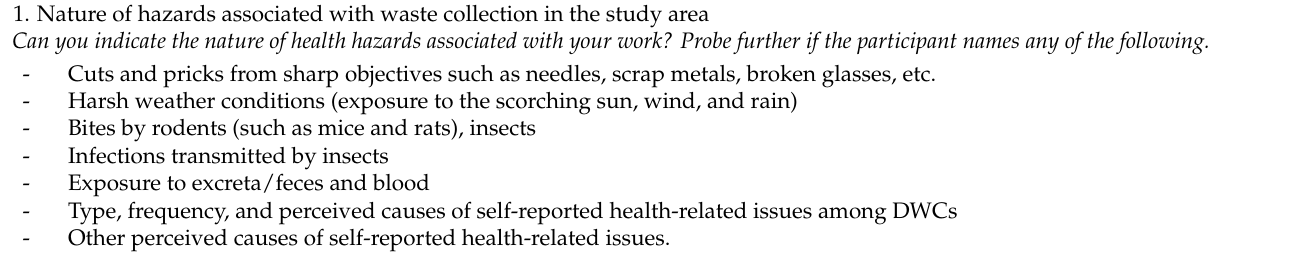
Table 2. Interview guide questions in the FGDs and